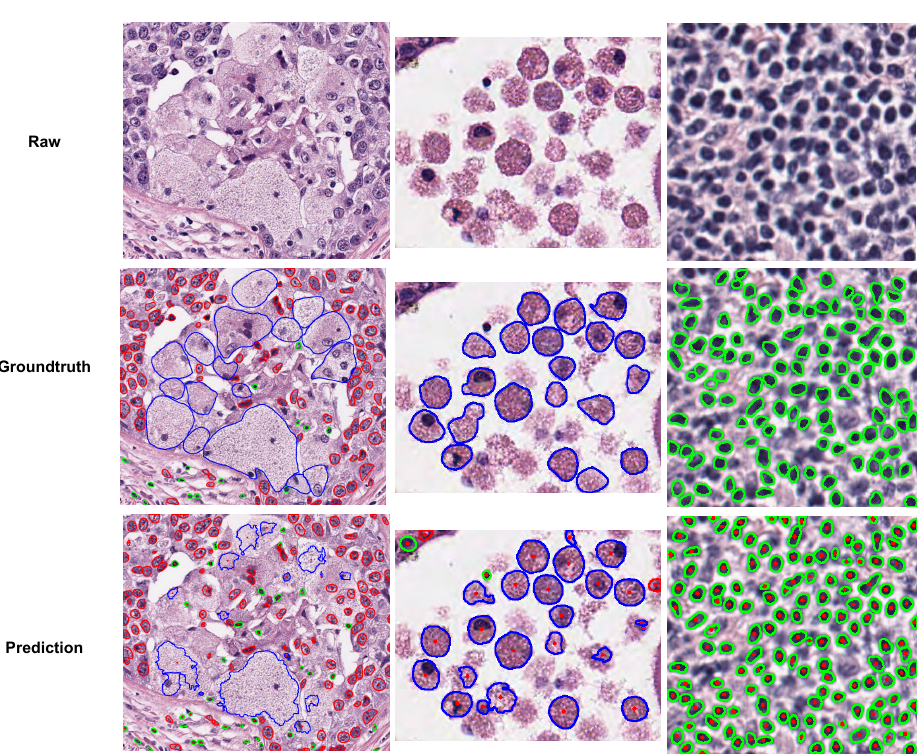
Figure 2. Sample tissue images from the MoNuSAC dataset with ground-truth annotations and prediction of Mulvernet